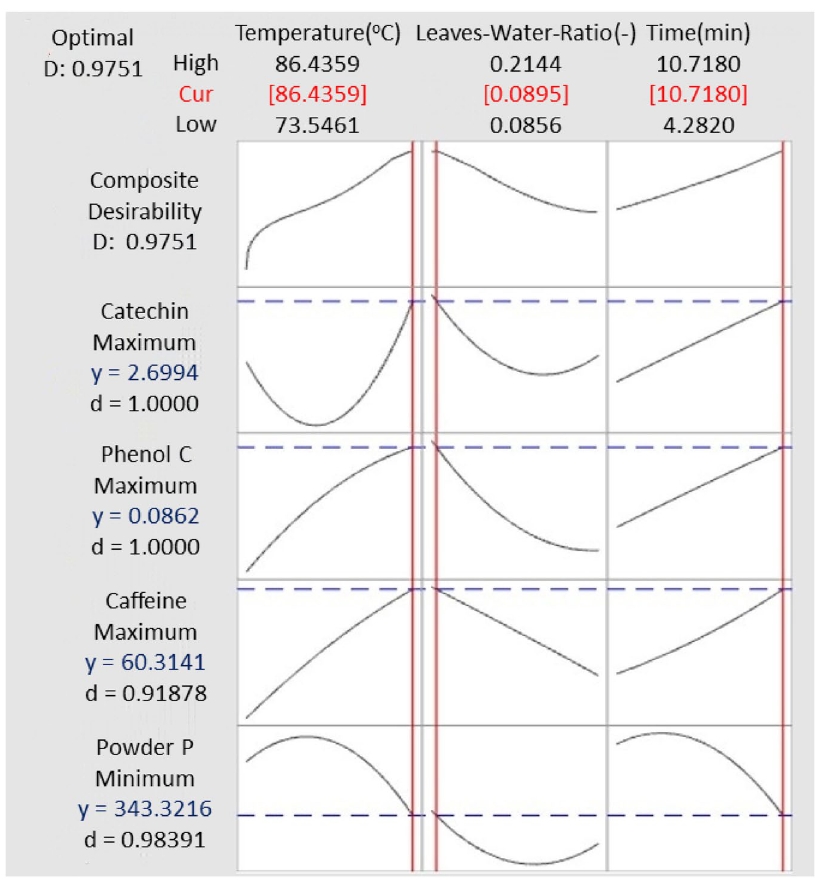
Figure 4. Multiple response prediction on the maximum value of catechin, caffeine and total phenolic contents regarding the minimum value of powder particle